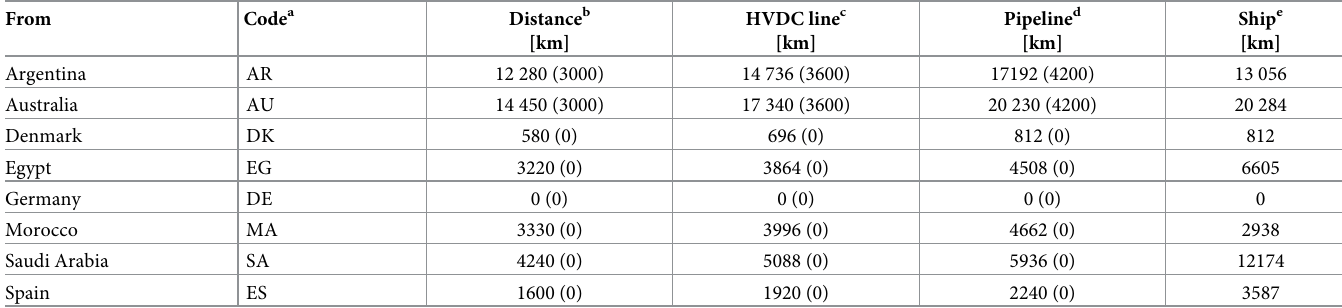
Bracketed values indicate the share of submarine distances considered.